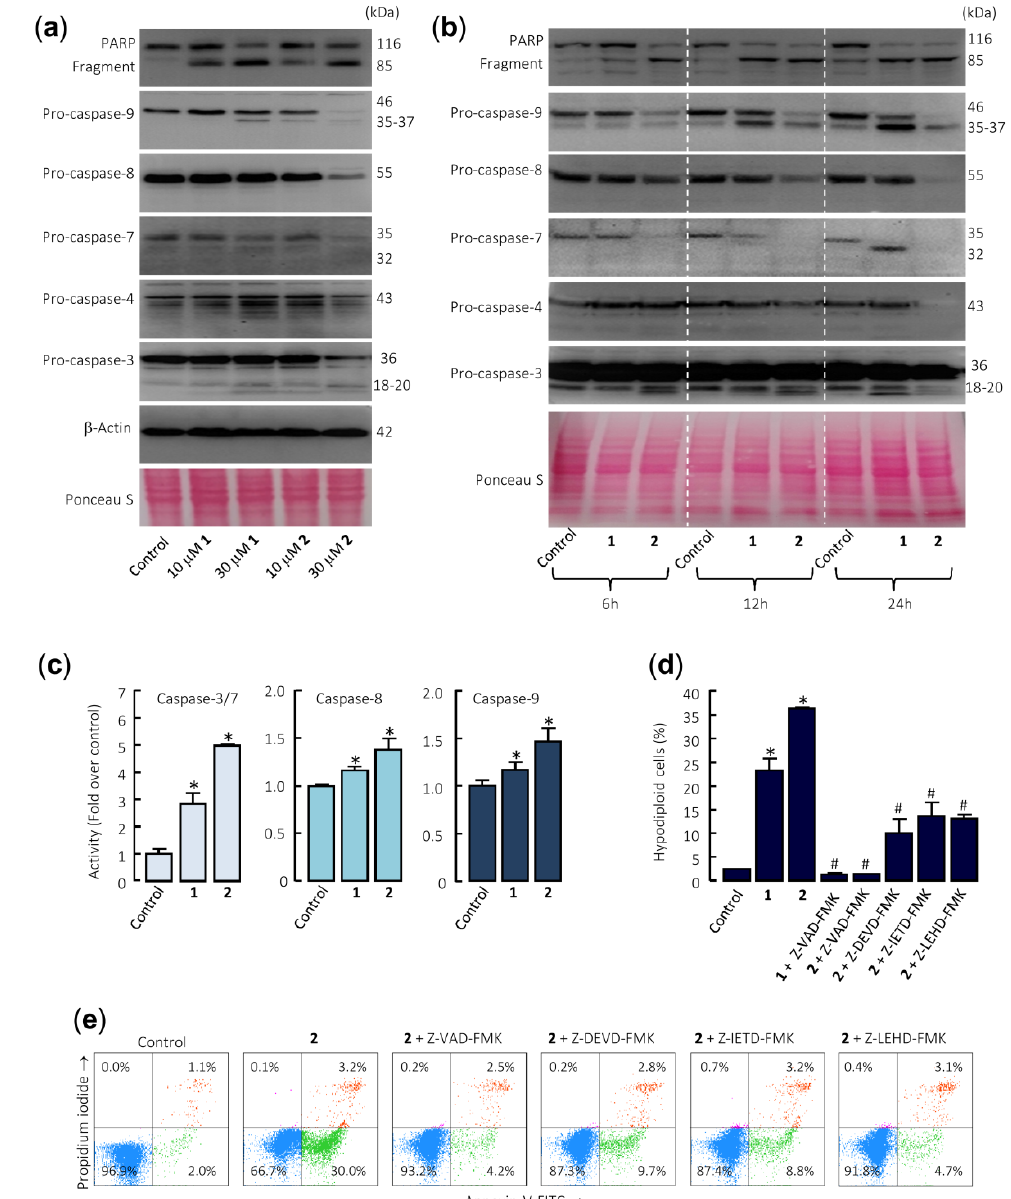
Figure 3. Caspase cascade is involved in apoptosis induction by sesquiterpene lactones in U-937 cells. ( a ) The cells were cultured for 24 h in control conditions or in the presence of the indicated concentrations of the specified compounds, and the cell lysates were analyzed by Western blots for the cleavage of poly(ADP-ribose) polymerase (PARP) and pro-caspases-3, -4, -7, -8, and -9. β -Actin was used as a loading control. Total protein loading was also controlled by Ponceau S staining (a representative stained membrane is shown). ( b ) Representative Western blots show the time-dependent PARP cleavage and pro-caspases processing in response to sesquiterpene lactones 1 and 2. Cells were incubated with 30 µ M of compounds for the indicated time points, and protein extracts were prepared and analyzed by immunoblotting using specific antibodies. The membrane was stained with Ponceau S to control equal protein loading. ( c ) Cells were cultured in control conditions or in the presence of 30 µ M sesquiterpene lactones for 24 h and lysates were assayed for caspase-3 / 7, -8, and -9 activities. Results are expressed as fold increase in caspase activity compared with control. Values represent means ± SE of three independent experiments, each performed in triplicate (* p <0.05, significantly different from untreated control). ( d ) Effects of caspase inhibitors on the percentage of hypodiploid cells. The cells were pretreated in the absence or presence of Z-VAD-FMK (100 µM) or